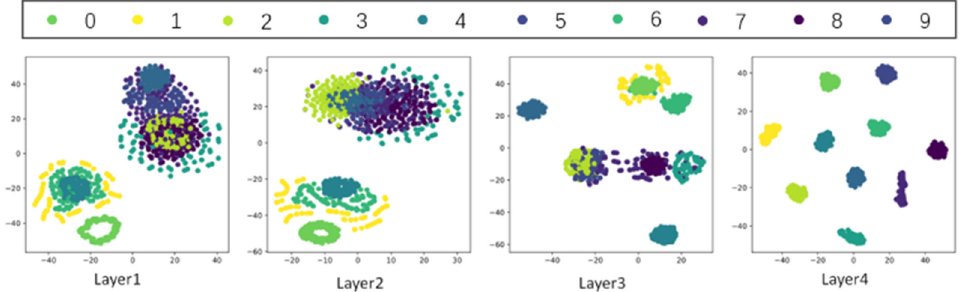
Figure 9. Fault feature extraction result.